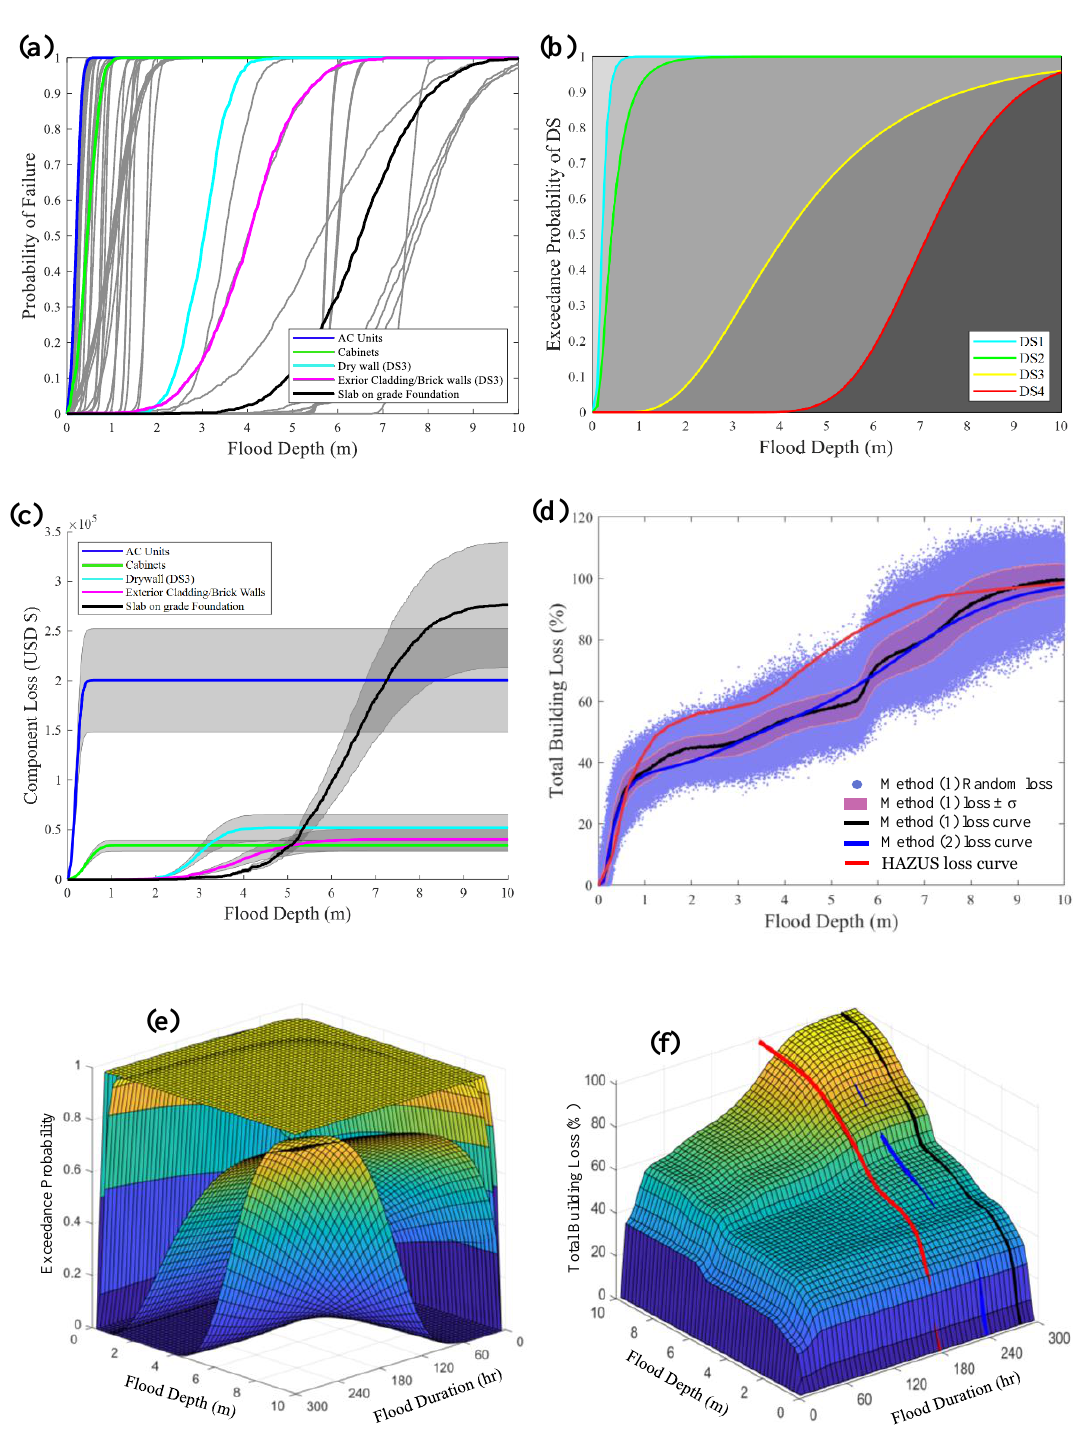
Figure A27. F13 archetype analysis results: ( a ) Component fragility curves; ( b ) Building fragility curves; ( c ) Selected components’ loss curves; ( d ) Building loss curves; ( e ) Building fragility surfaces; ( f ) Building loss surface.